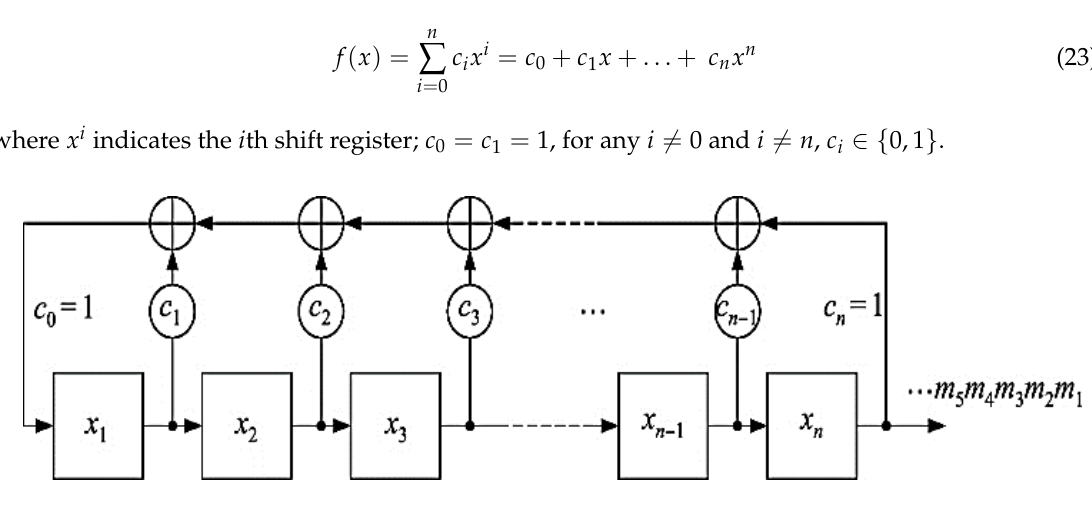
Figure 4. Pseudo-random code linear feedback shifter register.